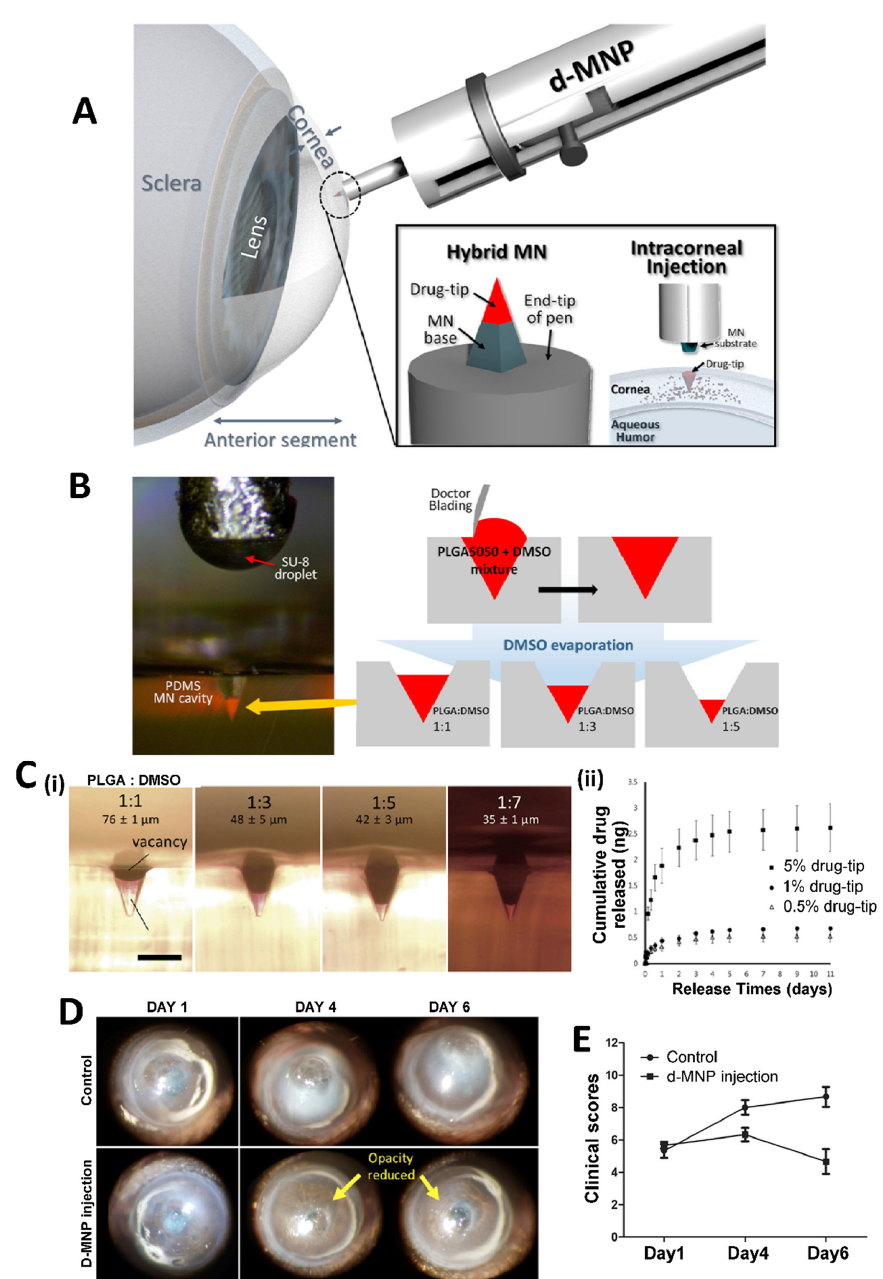
Figure 4. ( A ) Schematic illustration of a detachable hybrid d-MNP system and its intracorneal injection. ( B ) Dimension optimization of a drug-tip by adjusting the PLGA concentration in the drug formulation and evaporating DMSO in the molding process of the drug formulation. ( C ) Premolded PDMS mold having a drug-tip-controlled height (scale bar = 100 μm) (i), in vitro cumulative release of model drug from 5%, 1%, and 0.5% drug-tips in PBS buffer solution (ii). ( D ) The representative images of Acanthamoeba keratitis for 7 days in control corneas (un-treated group) and corneas treated with d-MNPs loaded with PHMB (d-MNP injection). ( E ) Clinical scores detected at each time point. Reprinted with permission from Ref. [119]. 2022,